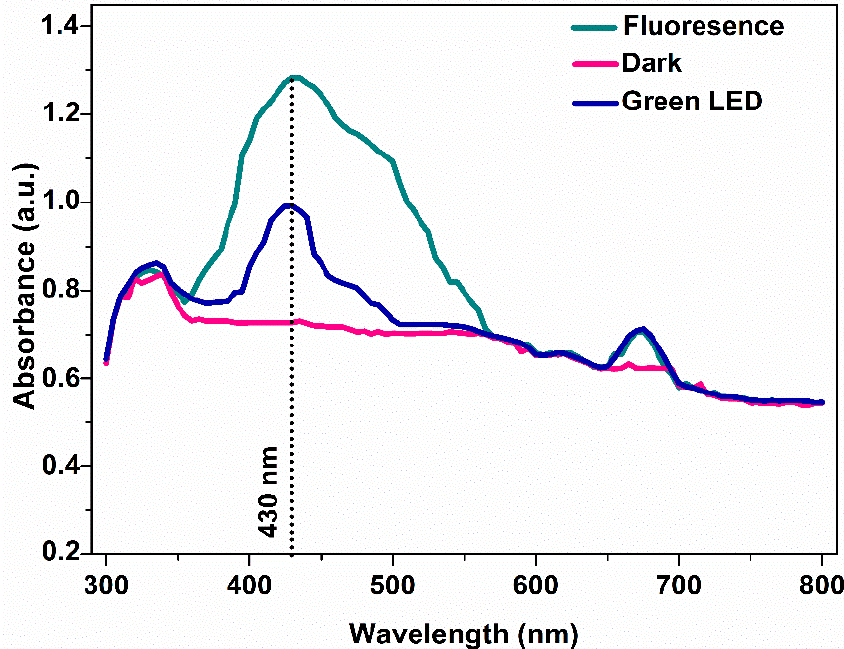
Figure 3. UV-vis spectra of produced AgNPs under different cultivation light conditions. Table 1. Effect of light wavelength on phycocyanin and PE concentrations on Pseudanabaena/Limnothrix sp. cells and AgNPs synthesis.